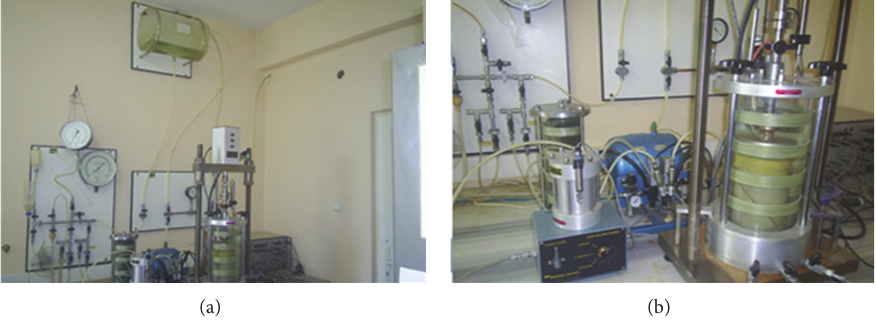
Figure 2: The cyclic triaxial test system.